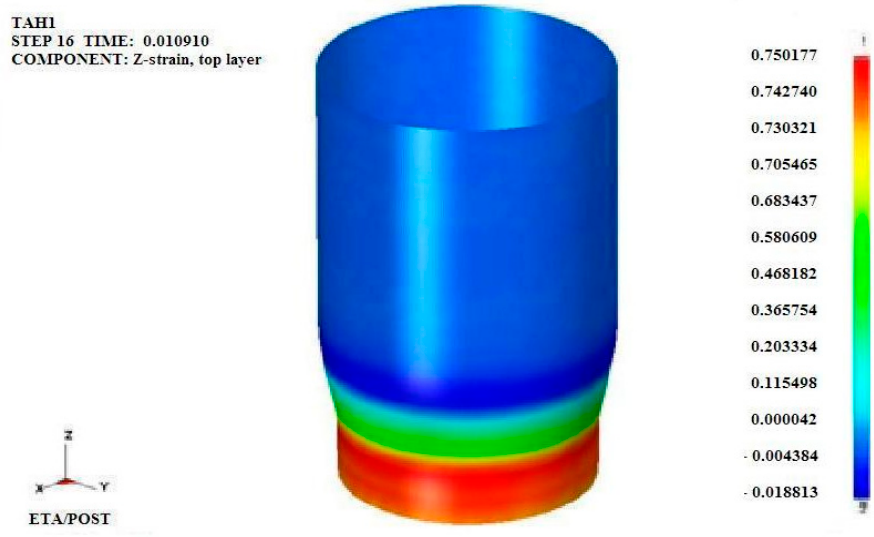
Figure 11. Drawing force at the first draw F = 0.740 kN. Figure 11 . Drawing force at the first draw F = 0.740 kN. Figure 11 . Drawing force at the first draw F = 0.740 kN.